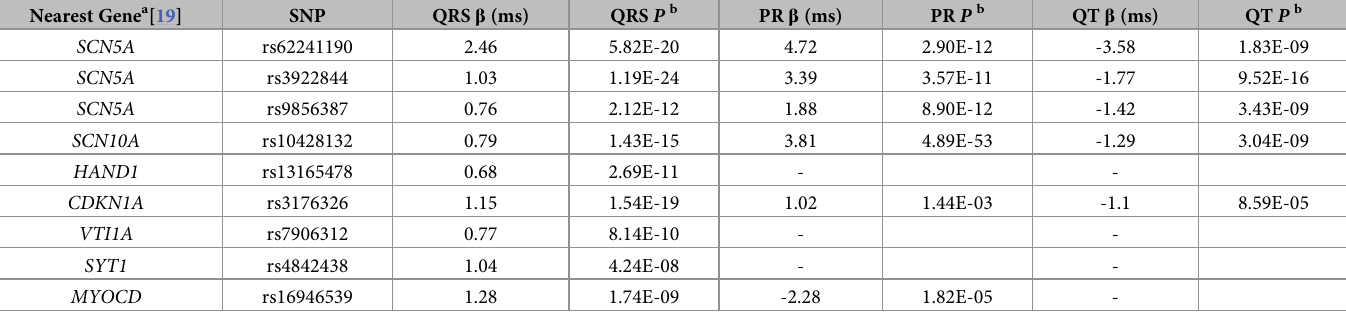
Table 2. Pleiotropic analyses. Comparison of the effect size and significance level of QRS prolonging index SNPs with QT and PR duration in Hispanics/Latinos. There was no association of QRS SNPs with heart rate or heart rate variability (SDNN). Only significant results ( P < 0.05) are shown. Nearest Gene a [19]